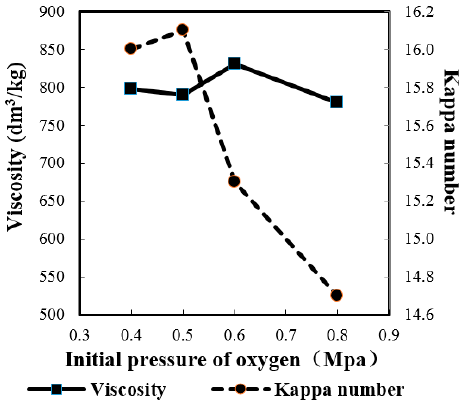
Figure 2. Influence of initial pressure of oxygen on viscosity and Kappa number.